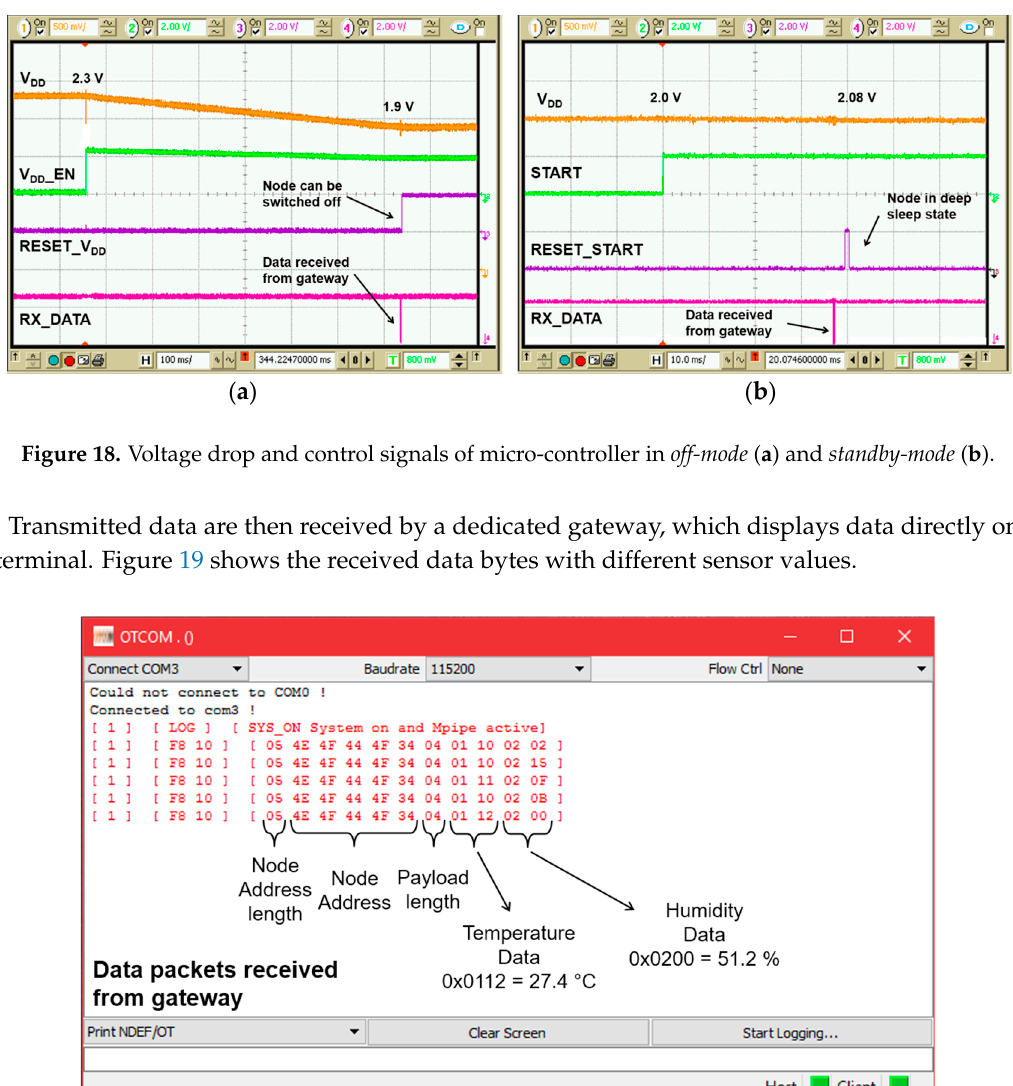
Figure 19. Data received format.